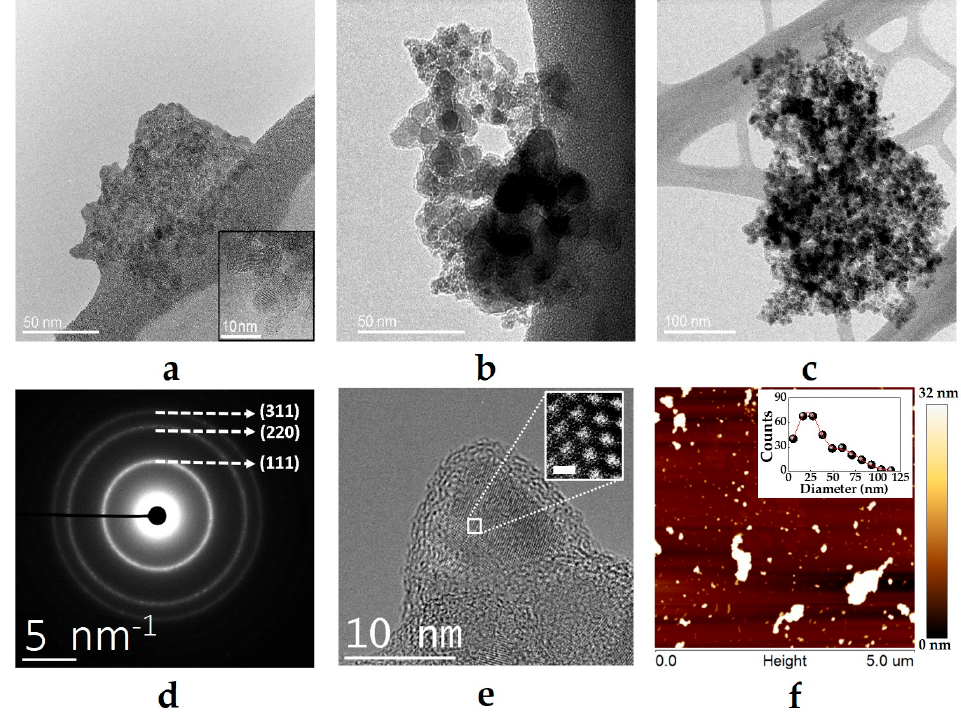
Figure 3. HRTEM images of ( a ) pristine NDs, ( b ) NDs@PDA, and ( c ) NDs@PDA@ICG. Inset in ( a ) shows the crystalline character of NDs with the graphitic surface. In the NDs@PDA and NDs@PDA@ICG, we could see the PDA layer encompassing the carbon nanoparticles. ( d ) The selected area diffraction pattern from the pristine nanoparticles. ( e ) HRTEM image of a single NDs, where the inset shows a high magnification of the NDs (scale bar: 1.54 Å). ( f ) AFM micrograph of NDs on mica sheet. The inset shows the size distribution of NDs clusters. The biggest clusters were excluded from the diameter measurements because of their irregular shape, as the diameters were obtained from ImageJ cell count